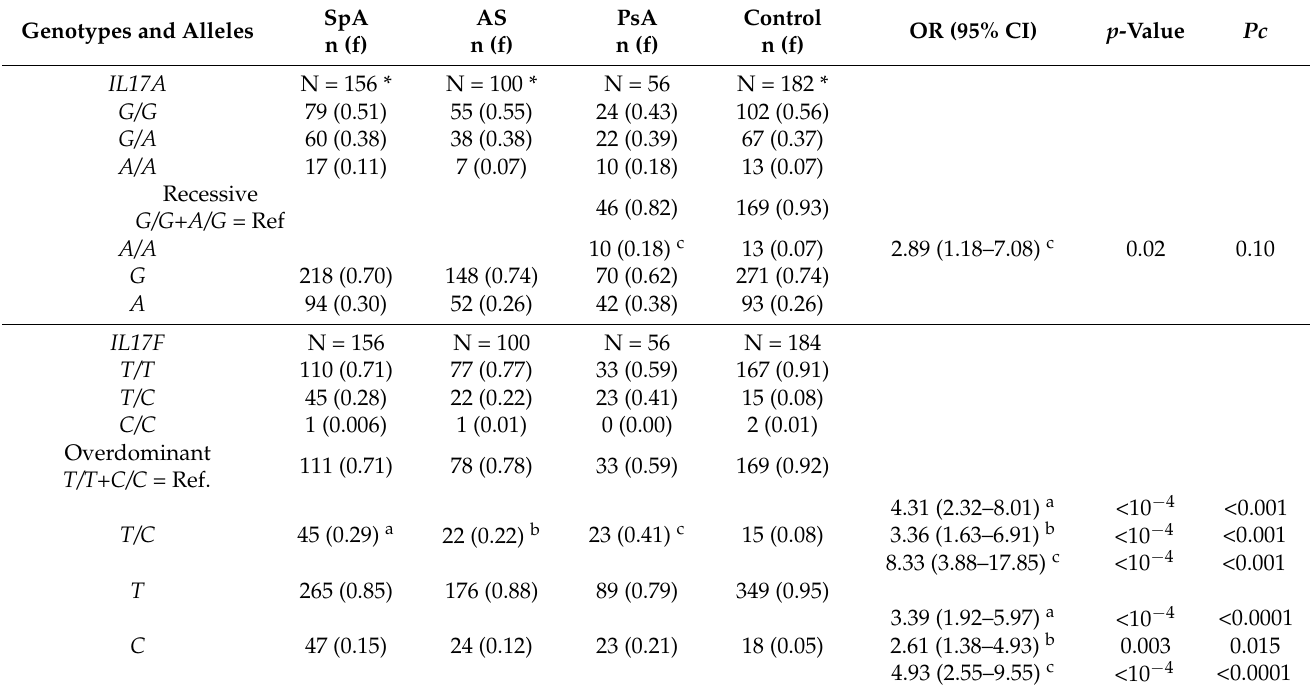
Table 2. Distribution of the allele and genotype frequencies of IL17A, IL17F , TNF -238, TNF -308, Fok I, Taq I, Apa I, and Bsm I in HLA-B*27 negative patients with SpA, AS, and PsA and controls. Genotypes and